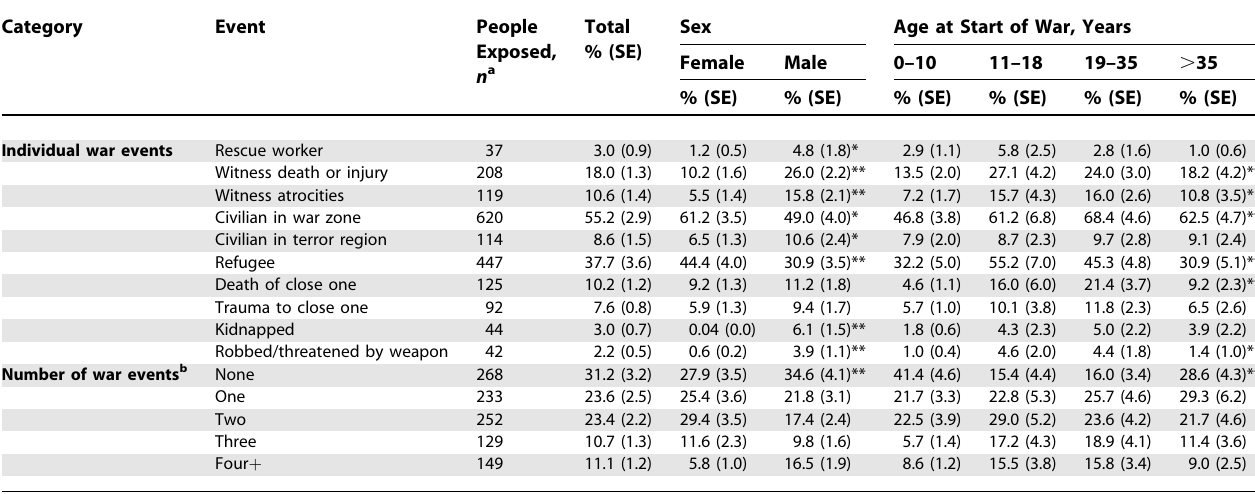
Table 3. Differences in Exposure to Individual and Cumulative War Events by Sex and Age at Start of War Category Event People Exposed,